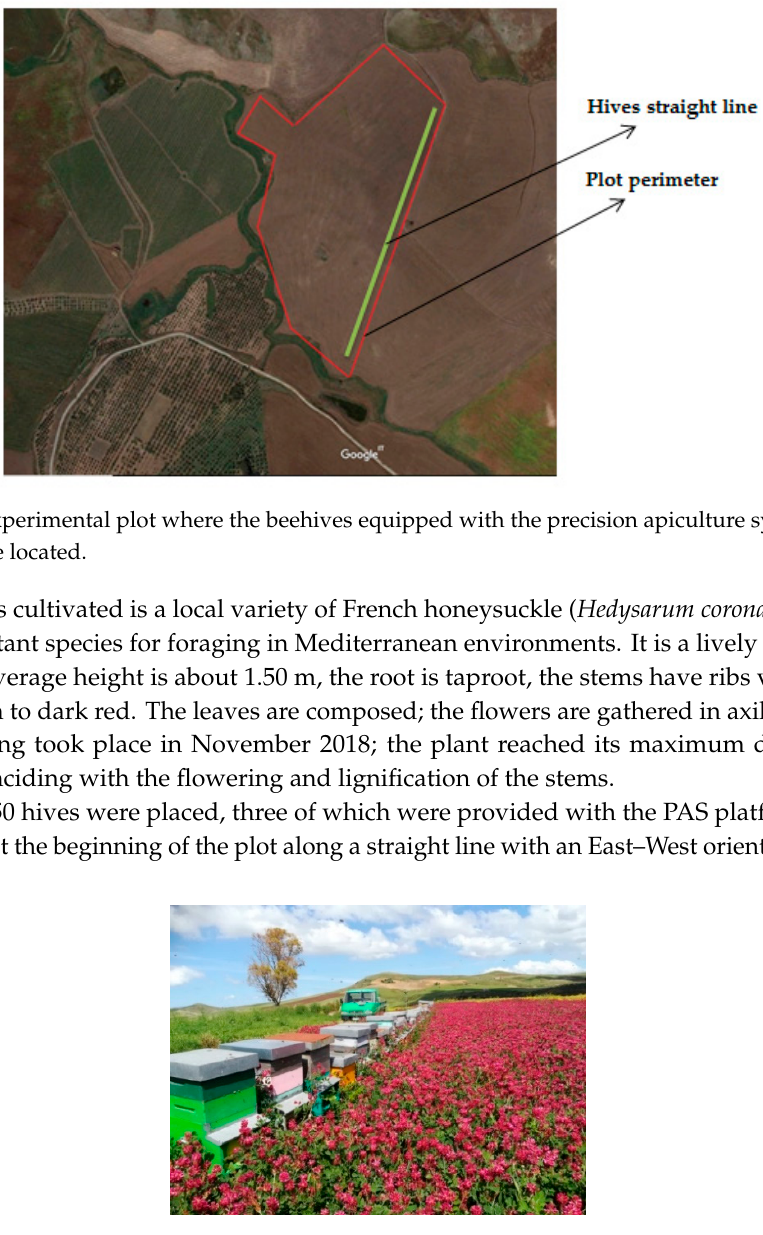
Figure 4. Hives in a French honeysuckle plot arranged along a straight line with an East–West orientation.